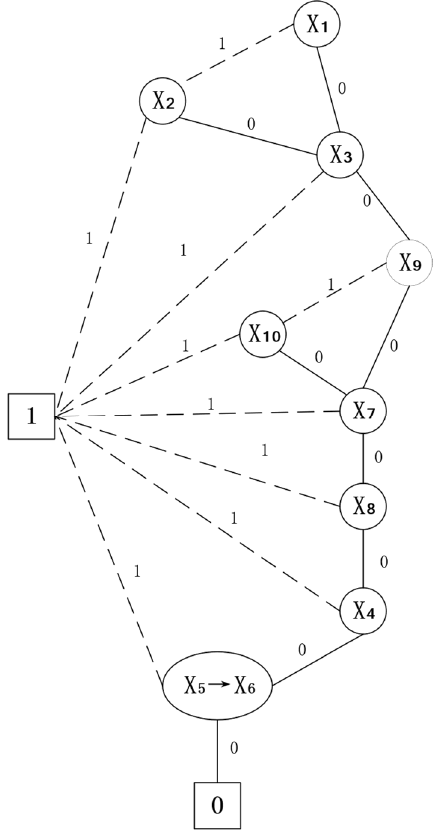
Figure 7. The binary decision diagram of automobile airbag system.